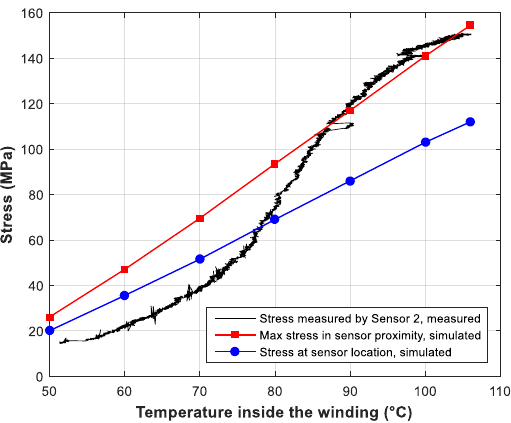
Figure 23. Comparison between the simulated and the measured stress in the yoke-side surface. The measured stresses are from Sensor 2.